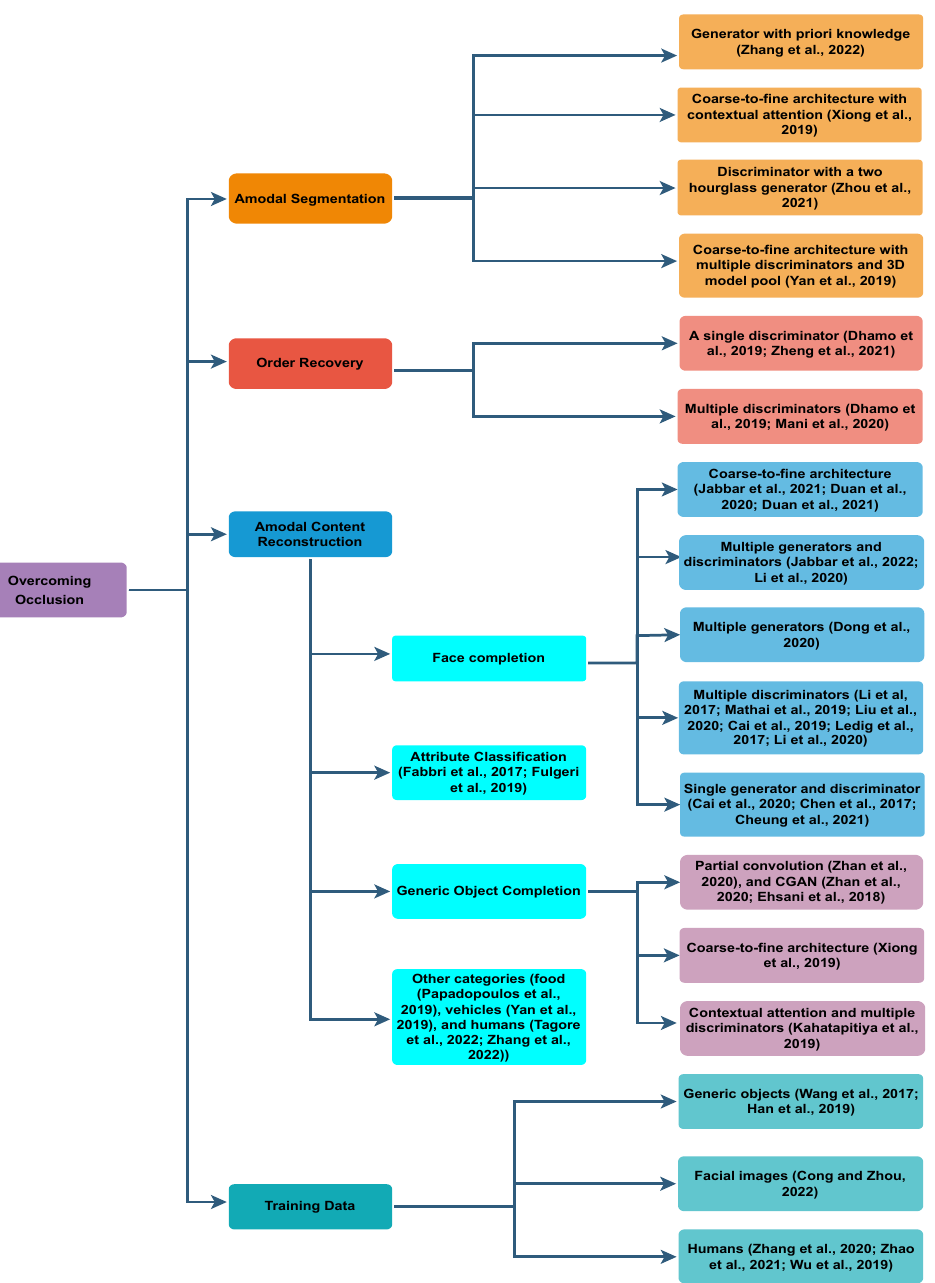
Figure 4. Outline of the approaches for addressing the challenges in overcoming occlusion through GAN. For amodal segmentation the implemented architecture are, a discriminator with a two hourglass generator [60], a coarse-to-fine architecture with contextual attention [63] or multiple discriminators [67], and a generator with priori knowledge [66]. For order recovery, GAN is designed as a generator with a single discriminator [71,73], or multiple discriminators [69,70]. To perform amodal content completion for facial images, the architectures include: a single generator and dis- criminator [79–81], multiple discriminators [82–87], multiple generators [88], multiple generators and discriminators [89,90], or a coarse-to-fine architecture [91–93]. Generic object completion is carried out through coarse-to-fine architecture [63], multiple discriminators with contextual atten- tion [78], or partial convolution and CGAN [75,76]. Human completion for attribute classification is utilized in [108,110]. Other works use GAN to complete the images of food [112], vehicles [67], and humans [66,114]. GAN is also used to generate training data of generic objects [115,117], hu- mans [113,119,120], and face images